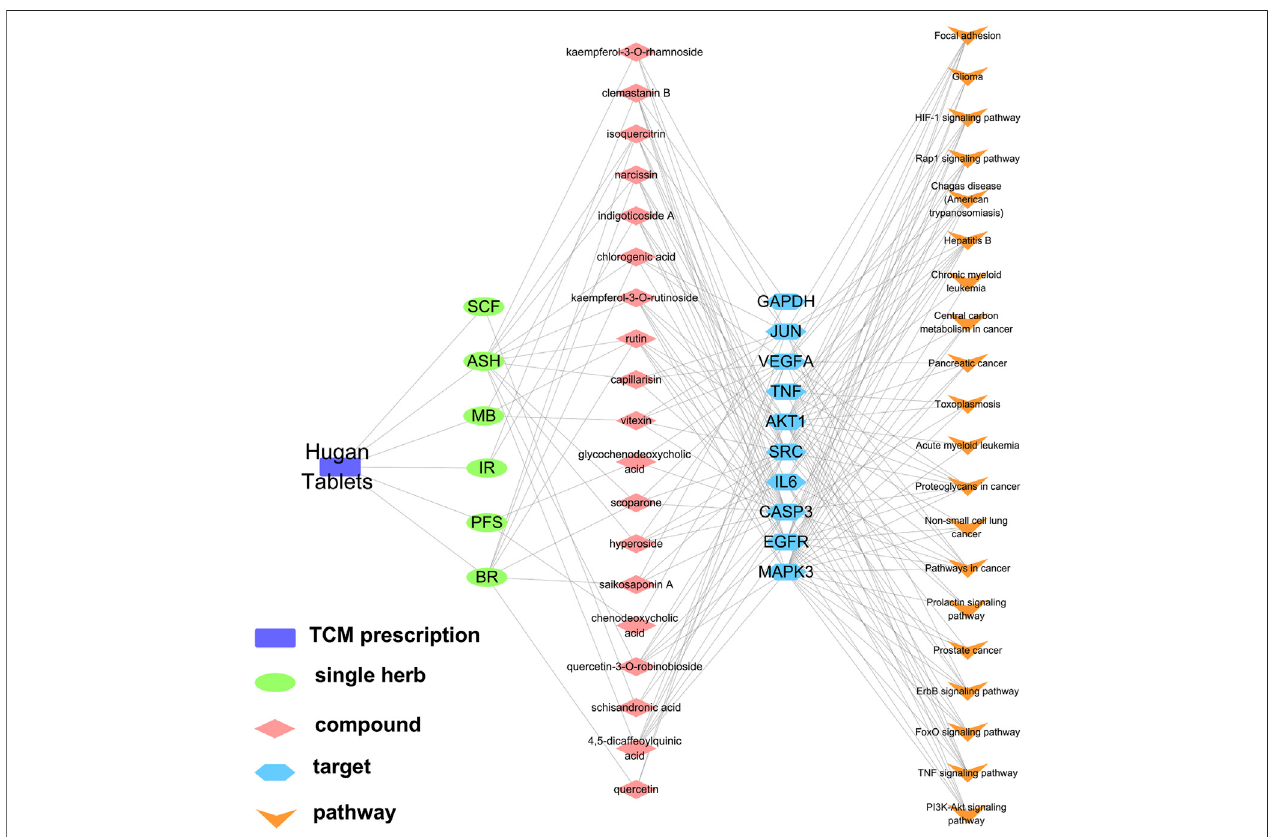
FIGURE 6 | Network diagram of “ TCM prescription – single herb – compounds – targets – pathways. ”